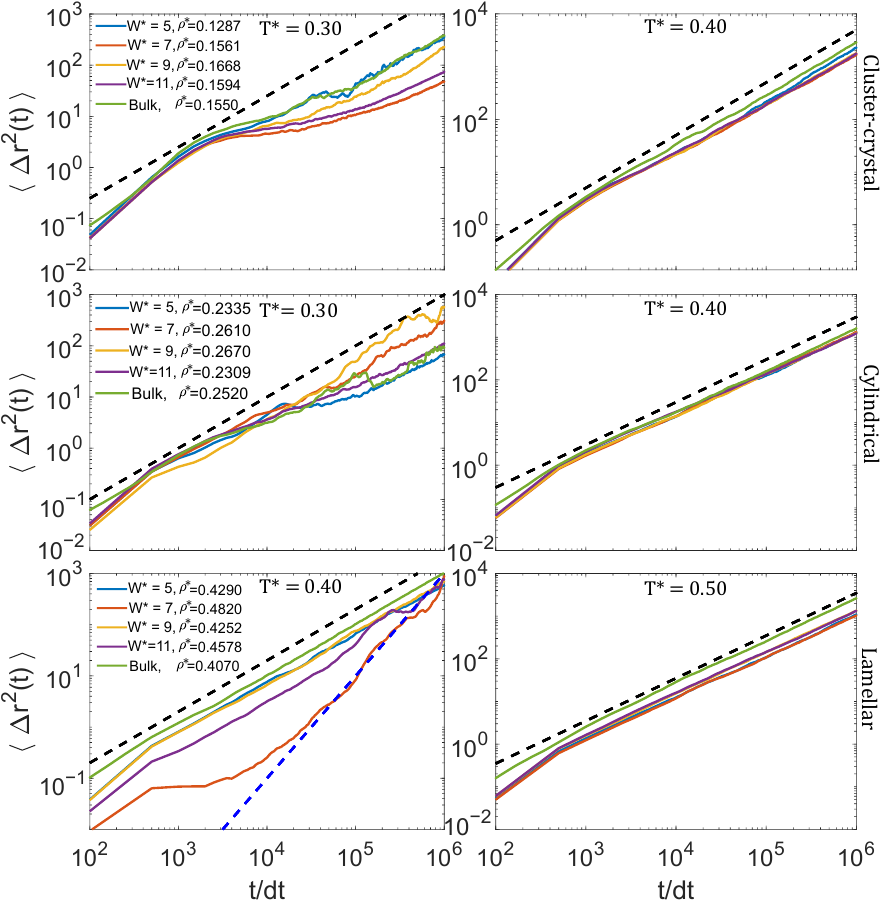
Figure 7. Particle mean squared displacement (MSD) of the fluid confined in slit pores of different width W ∗ at different temperatures at densities at which the cluster-crystal ( top row), the cylindrical ( middle row) and the lamellar ( bottom row) phases are stable. For comparison, the MSD for the bulk system under similar thermodynamic conditions are also included. The dashed black and blue lines show the expected behaviour for diffusive (MSD ∝ t β , β = 1) and ballistic ( β = 2) behaviour. * T *= 0.30 T *= 0.40 T *=0.50